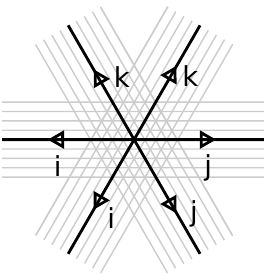
Figure 10 . The local structure of the WKB ij -, jk - and ki -foliations around a generic point of C